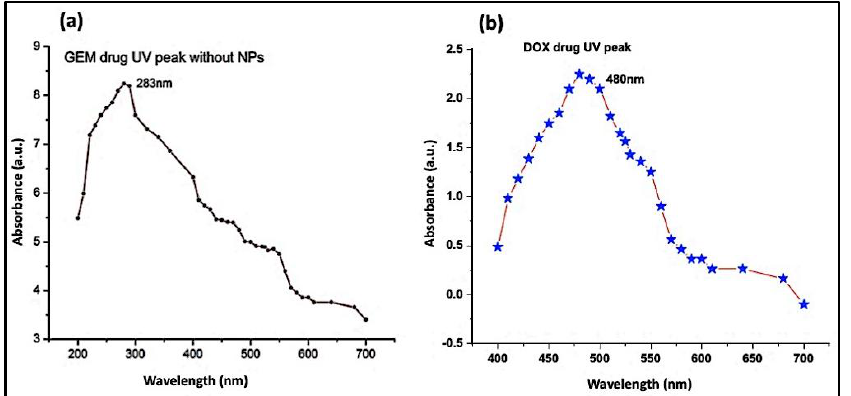
Figure 6. Absorption spectrum of ( a ) doxorubicin (DOX) and ( b ) gemcitabine (GEM).